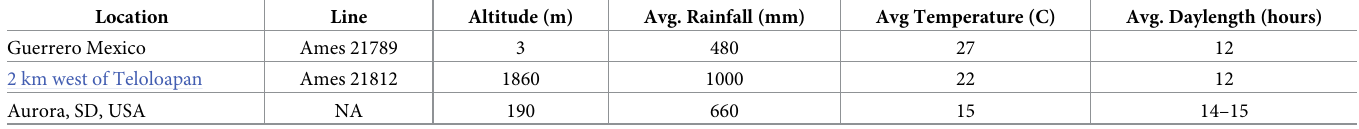
Table 2. Climate information for seed source locations and experimental site.